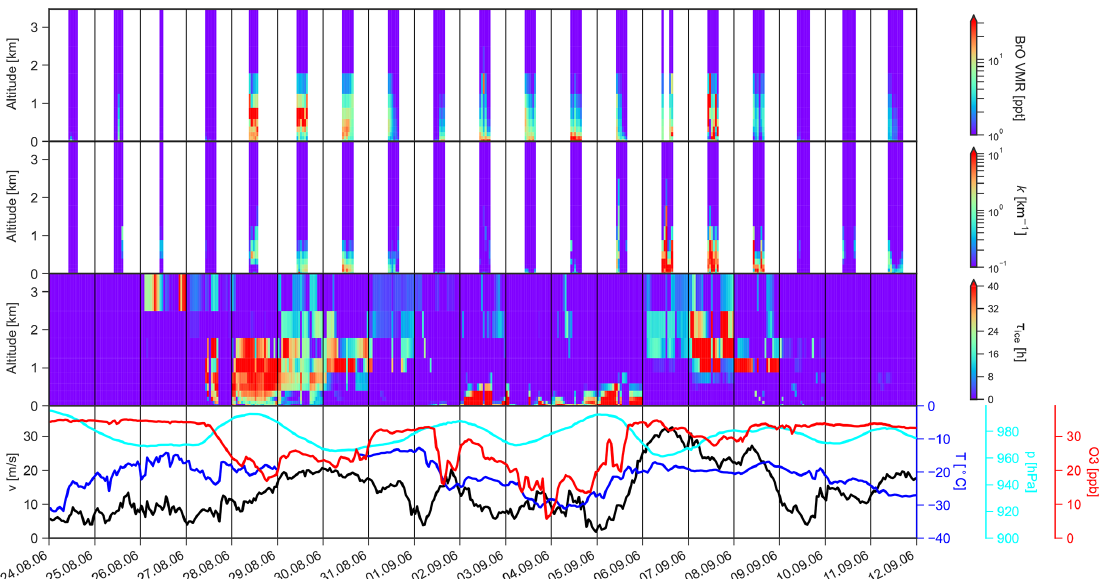
Figure 5. Example for a BrO enhancement episode at NM during August–September 2006, showing (from top to bottom) (1) BrO VMR profiles; (2) aerosol extinction profiles; (3) profiles of the duration of sea ice contact; and (4) wind speed (black), surface temperature (blue), pressure (cyan), and surface ozone VMRs (red). Note the logarithmic colour scale of the BrO and aerosol extinction profiles. Dates and times are given in UTC.